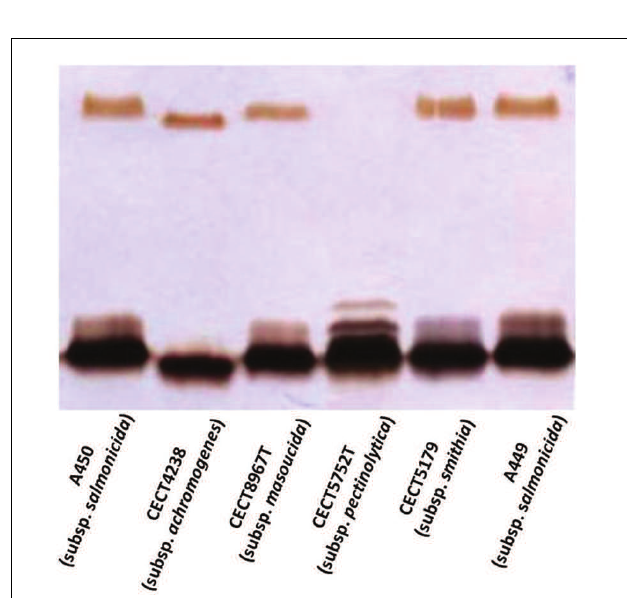
FIGURE 4 | Lipopolysaccharide (LPS) analyzed by SDS-Tricine gel and silver stained from the different subsp. of A. salmonicida